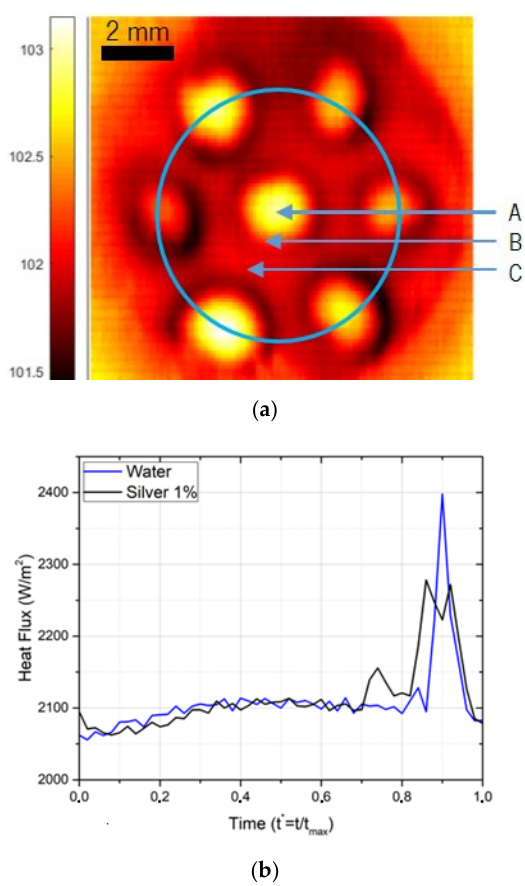
Figure 9. ( a ) Temperature map of the regions of interest for the heat-flux analysis in a biphilic surface with seven superhydrophobic regions. ( b ) Average dissipated heat flux for a septuple superhydrophobic region nucleation. The distance between superhydrophobic regions is δ = 1 d , and the imposed heat flux is 2132 W/m 2